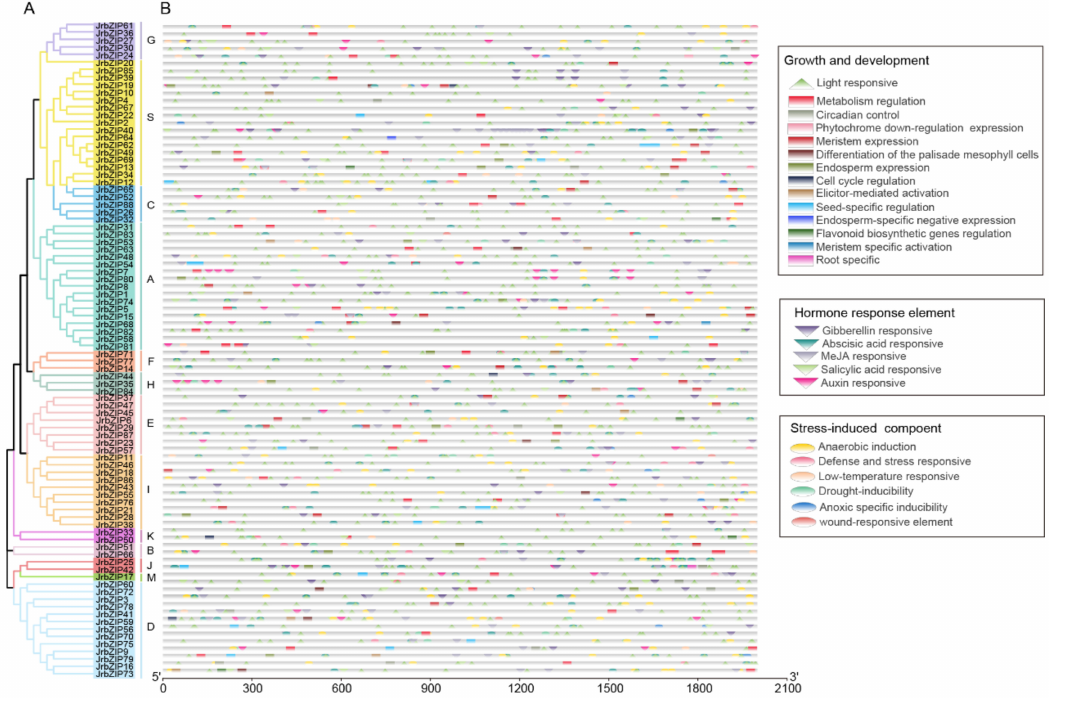
Figure 2. Phylogenetic relationships ( A ), and distribution of cis-elements in the promoter regions of JrbZIPs ( B ). The cis-acting elements were identified by PlantCARE using the upstream 2000 bp sequences of the JrbZIPs